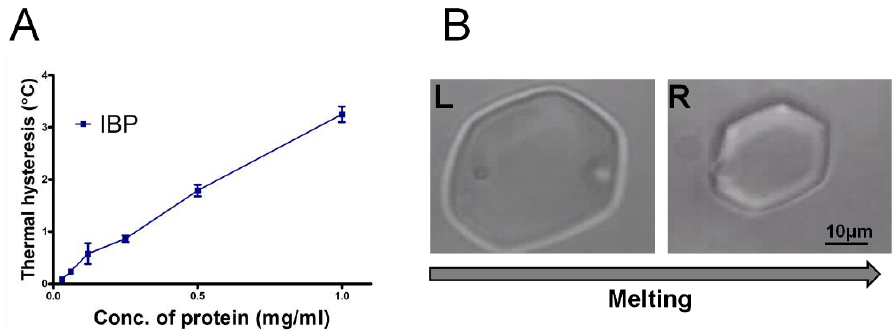
Figure 8. ( A ) Thermal hysteresis activity as a function of the concentration of the ice-binding protein (IBP) fraction after ice-affinity purification. ( B ) Ice morphology in the presence of IBP fraction during melting at a concentration of 0.25 mg/mL (40 µM). The time difference between the L and R image is 1.9 sec .